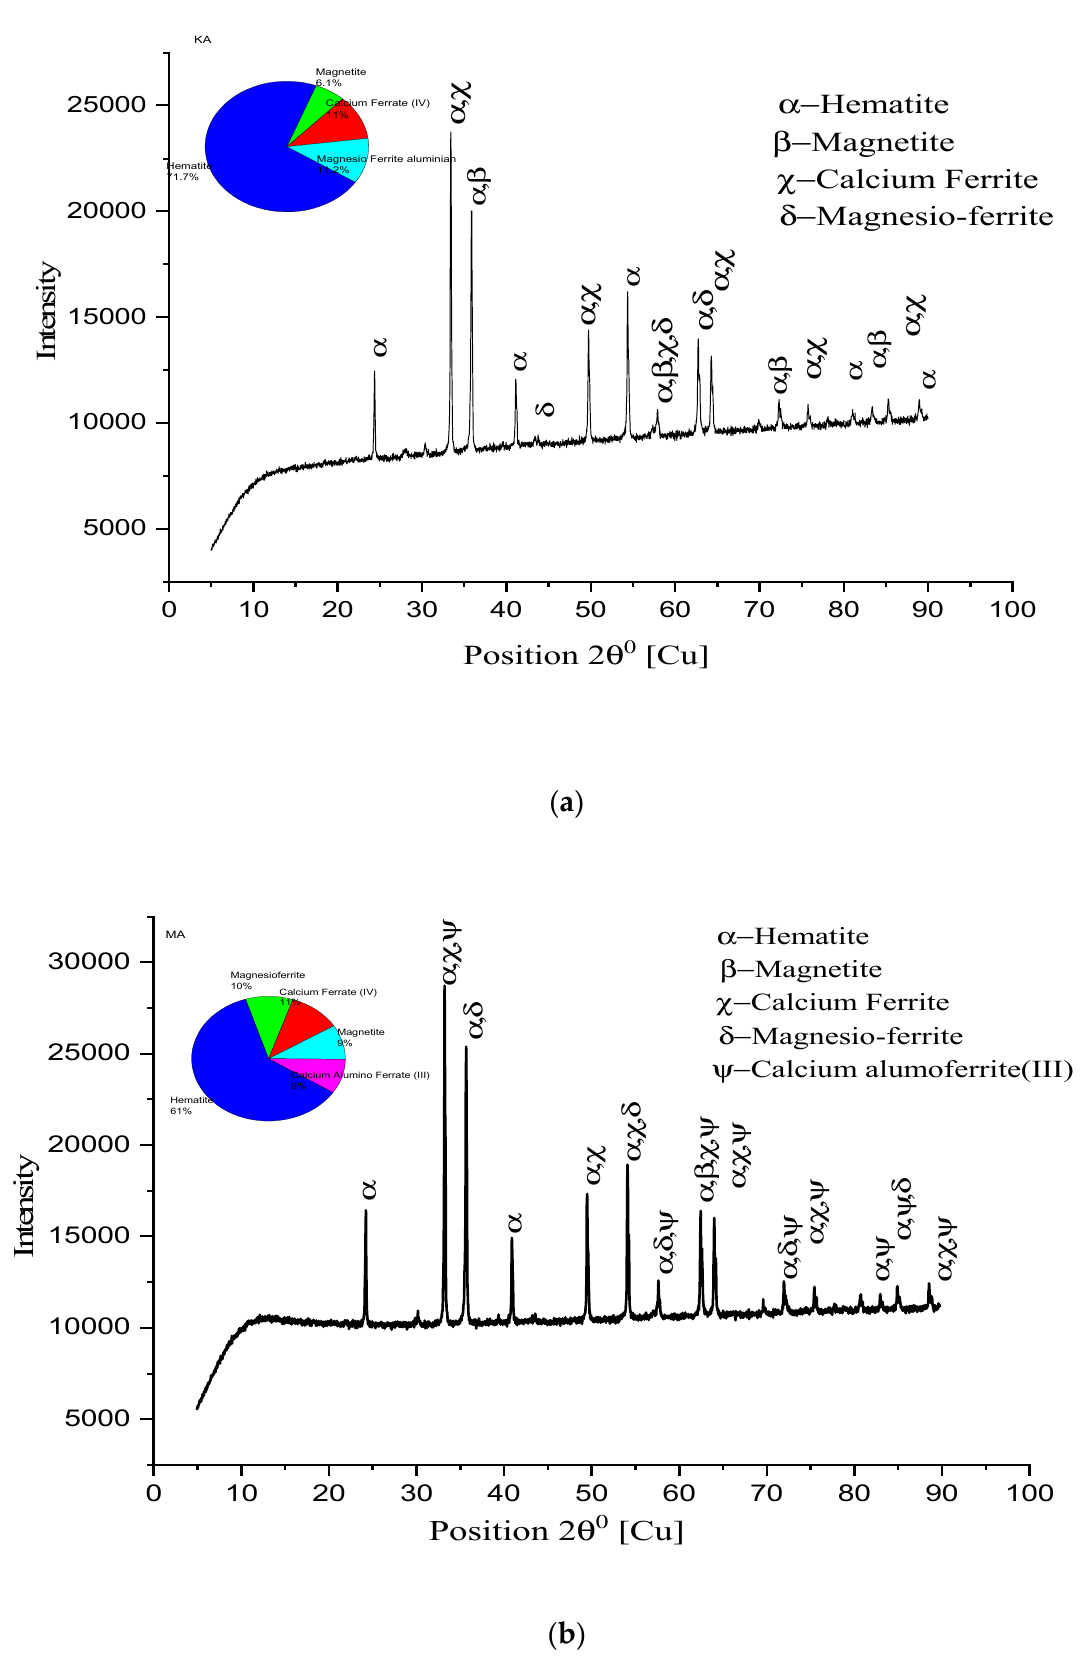
Figure 12. XRD patterns of pellet ( a ) K2A and ( b ) M2A.